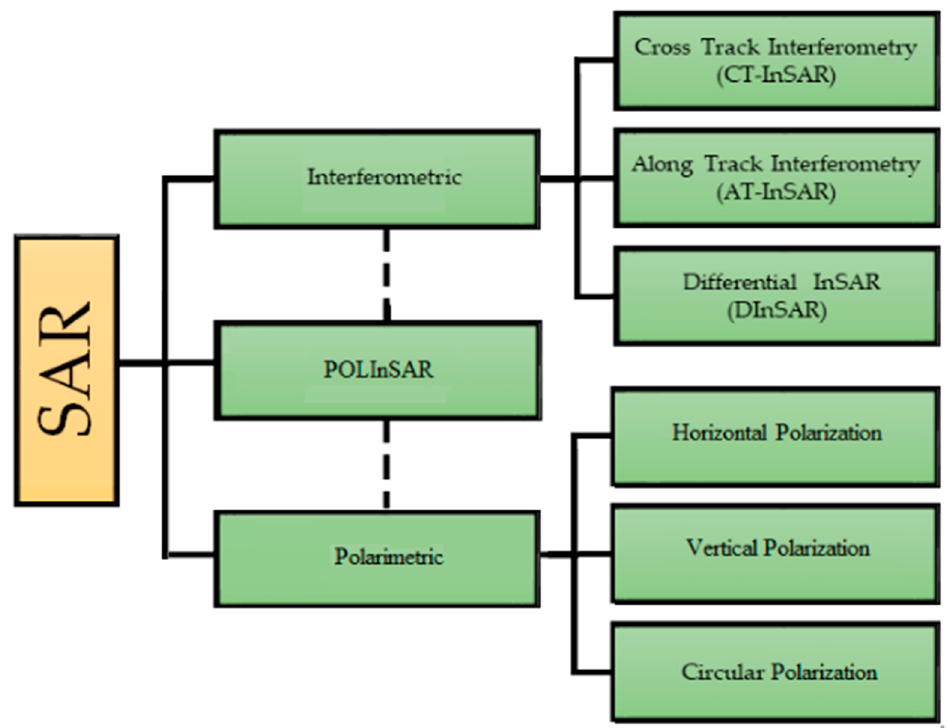
Figure 4. A simplified SAR classification. Solid lines are definitive classification and dashed line are the possible combination